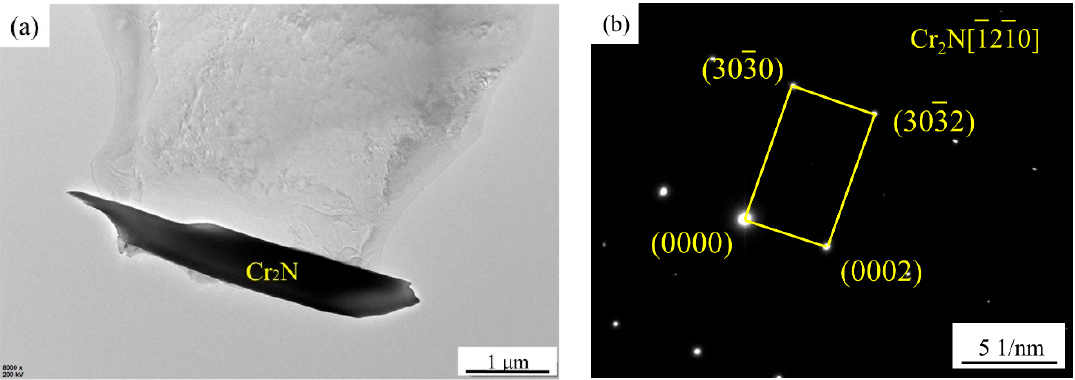
Figure 6. TEM images ( a ) and SAED patterns ( b ) of precipitates of the specimens after solution treatment at 1200 °C.